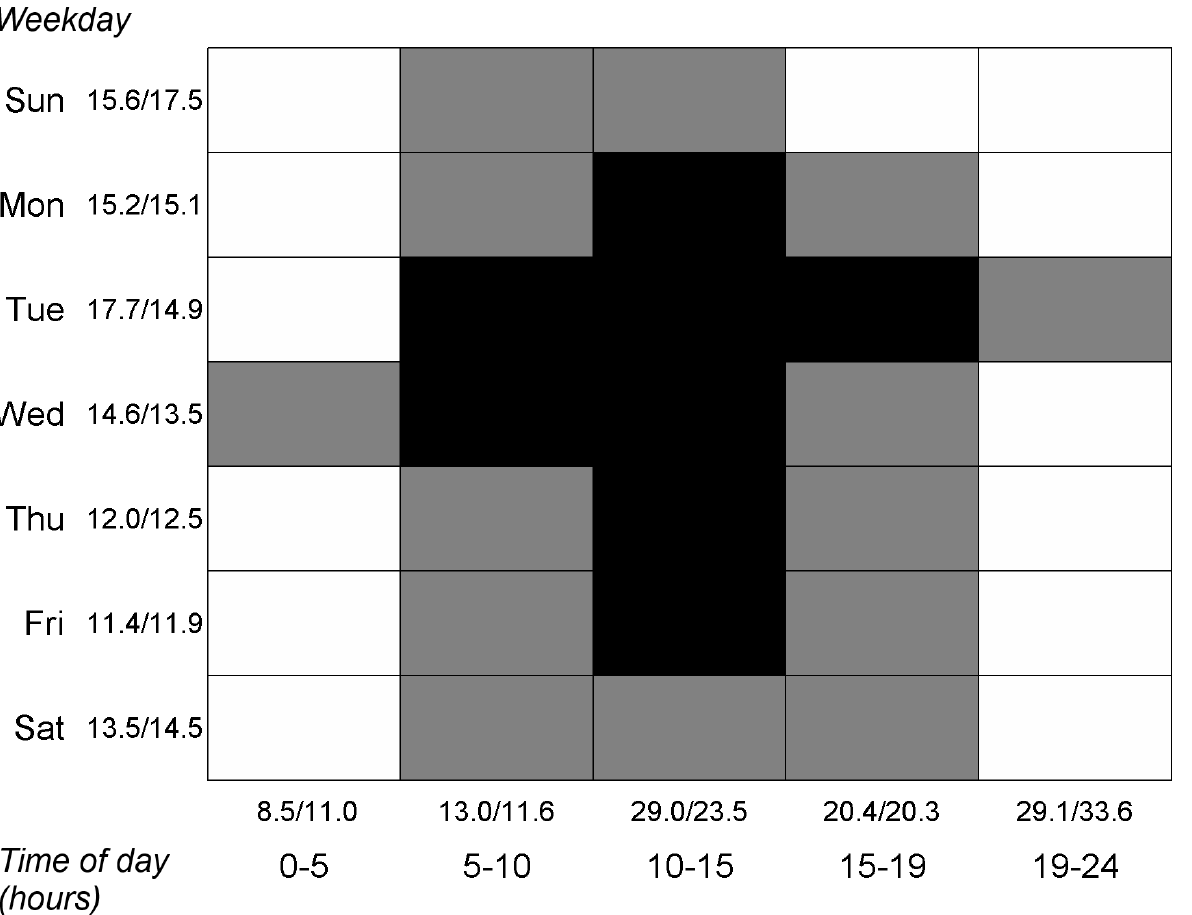
Figure 2. Correlations between users’ adherence level and their local registration time. Black=higher proportion of Users ( P <.0014); White=higher proportion of Dropouts; Grey=no difference. Numbers separated by slashes next to weekday and time of day labels are percentages of Users/Drop-outs for corresponding rows and